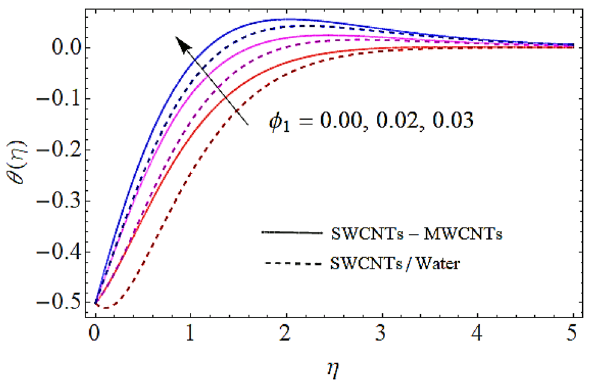
Figure 6. Thermal profiles versus φ 1 when M = 0.5, (cid:31) = 0.3, φ 2 = 0.02, K = 0.7, Pr = 12, R H = 0.6 .